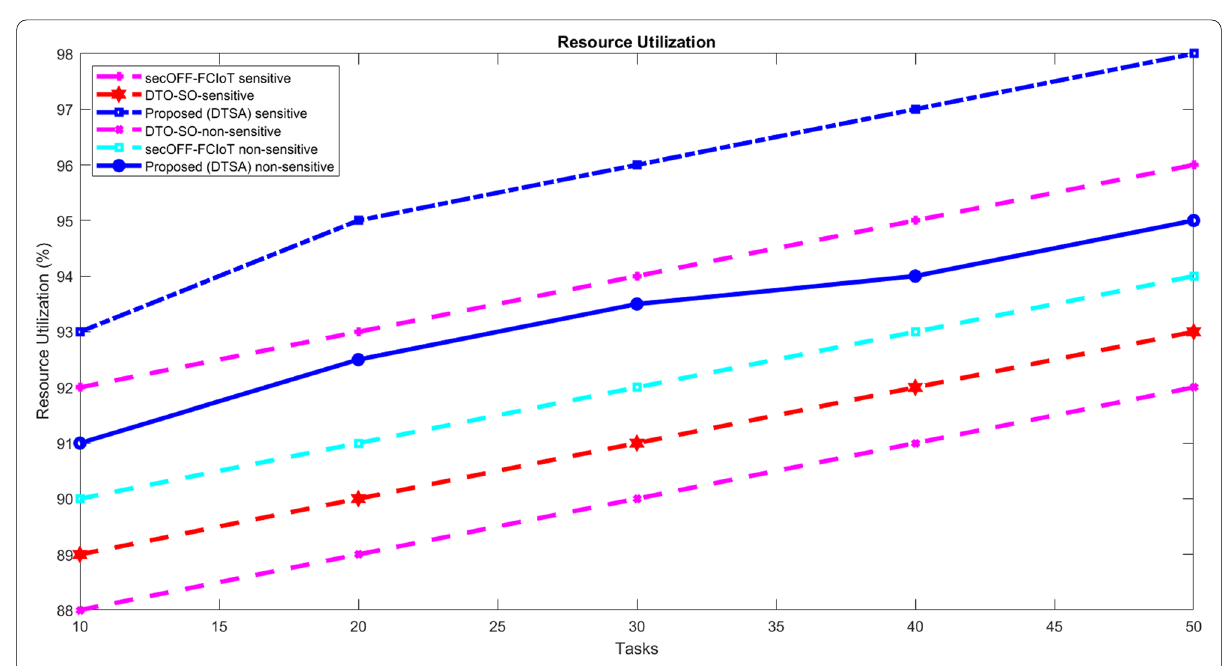
offload-able task to minimize the delay during the task offloading process. Introducing a new technology as an attribute reduction method in task offloading enables